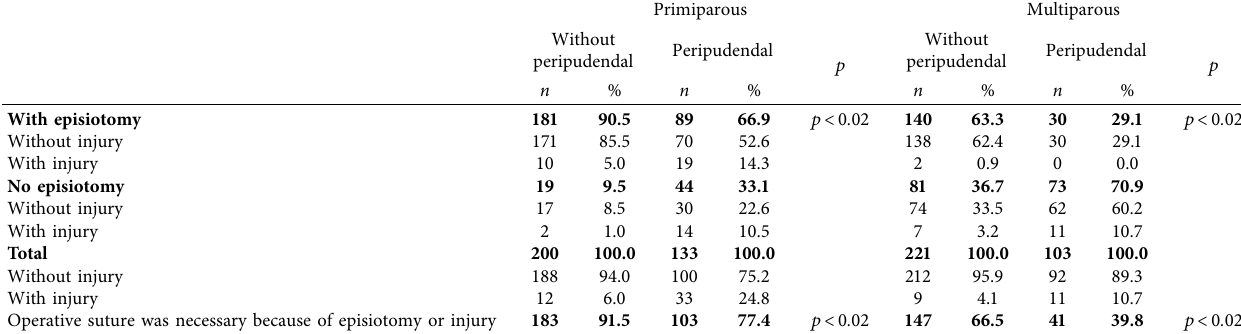
Table 2: Rate of episiotomy and perineal and/or vaginal injuries depending on whether peripudendal block was used or